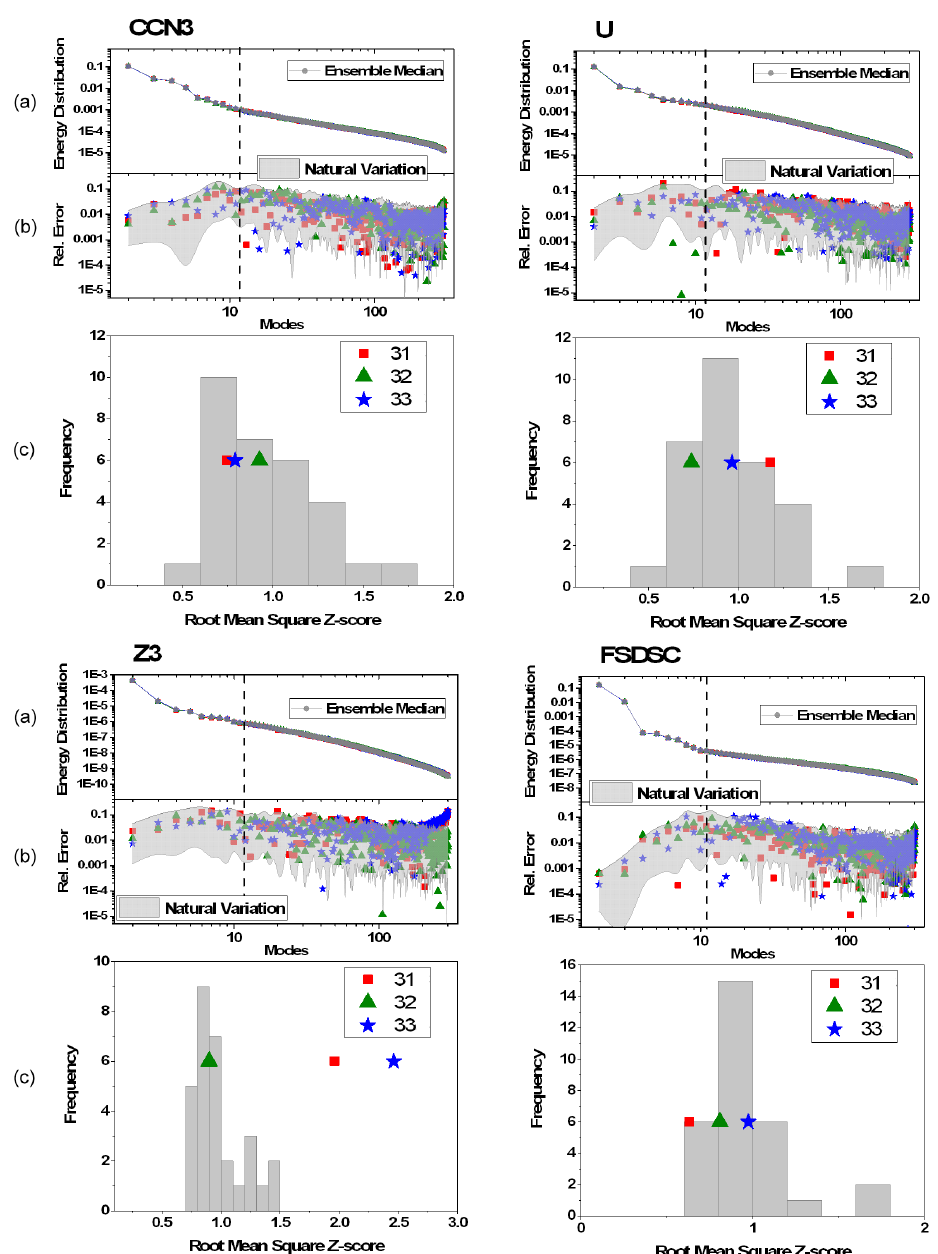
Figure 16. For each of the four variables studied, we show the following: (a) energy distribution of the modes of the POD for ensemble members 31–33, superimposed on the median of the original ensemble members (1–30); (b) relative errors of the energy distributions of the modes of the POD for new ensemble members 31–33 and the median of the original ensemble together with the natural variability observed within the uncompressed ensemble; (c) RMSZ distribution of the energy distribution for the 30 members of the original ensemble together with the RMSZ score of the energy distribution of new members 31–33. Note that members 31 and 33 have been subjected to lossy